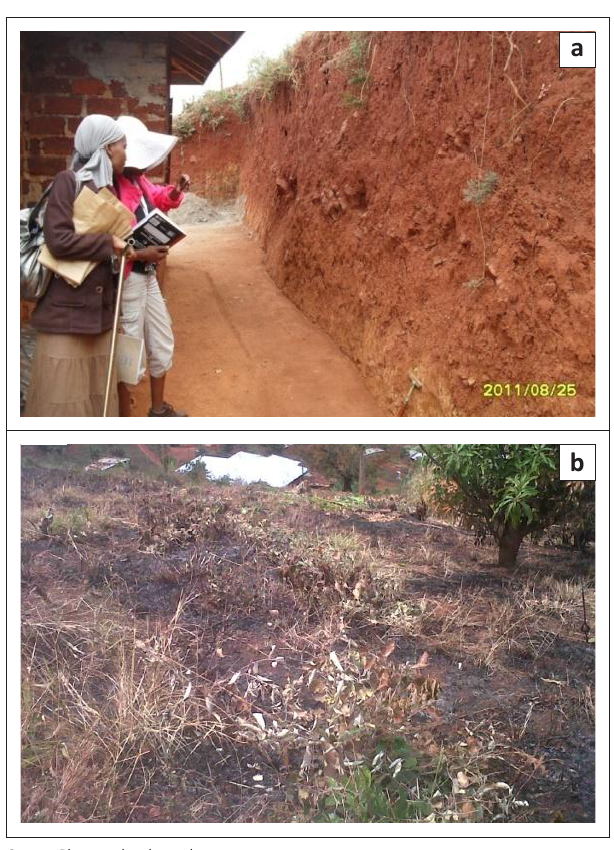
FIGURE 4: Anthropogenic activities on slopes at Dzanani include, (a) digging of foundations and (b) slash-and-burn